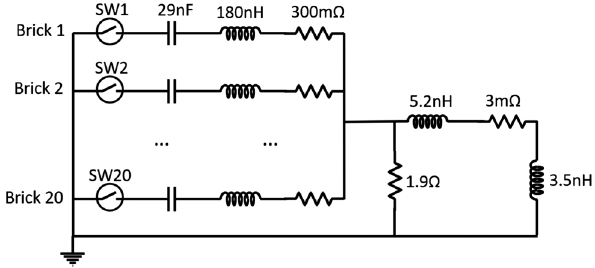
FIG. 6. Circuit model of the CESZAR machine with the 20 bricks in parallel, the magnetic cores modeled as 1 . 9 Ω shunt resistance, the power feed modeled as a 5.2 nH inductance, 3 m Ω resistance, and a 3.5 nH short-circuit